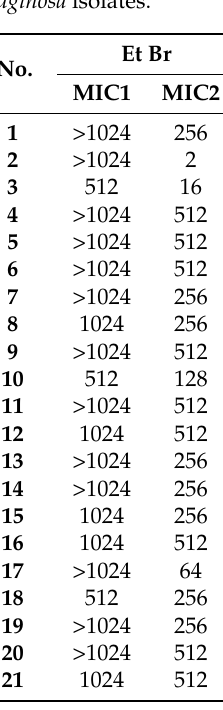
Table 3. Effect of addition of CCCP on antibiotic resistance pattern against 25 MDR Pseudomonas aeruginosa